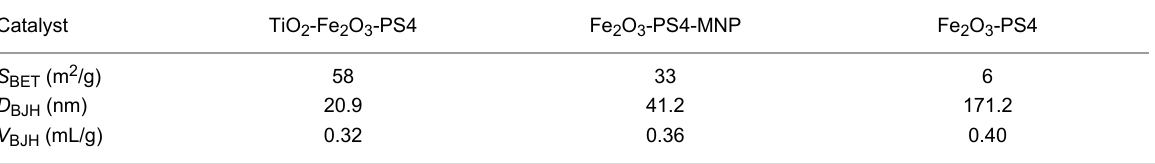
Table 1: Textural properties of iron oxide/polysaccharide